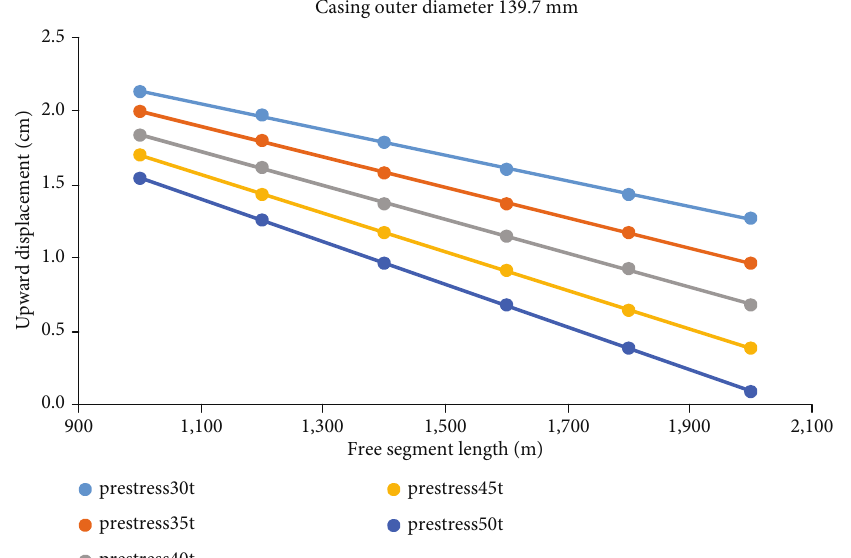
Figure 12: The relationship between moving up amount on casing with free segment length under di ff erent prestresses of three-open wells (casing outer diameter 139.7 mm).